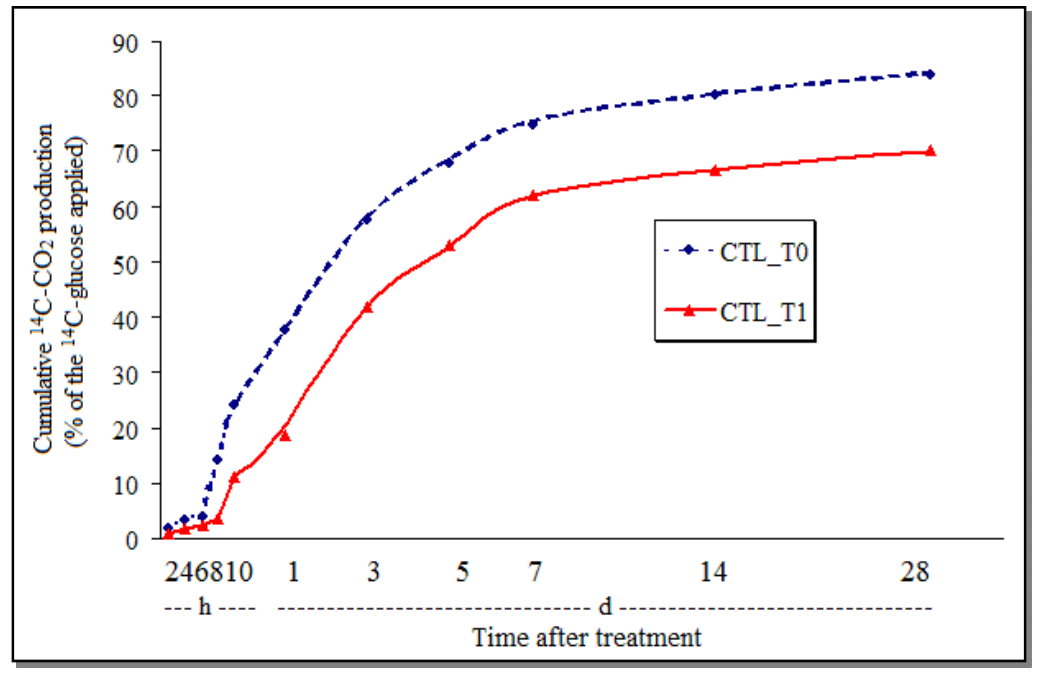
Figure 2. Cumulative production of 14 C-CO